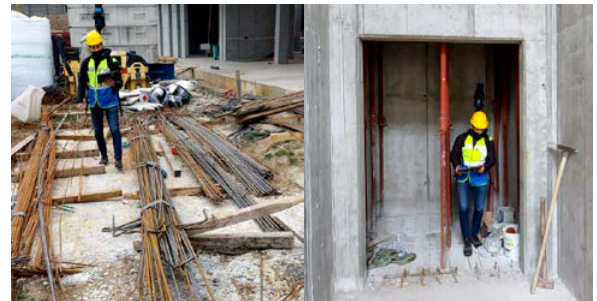
Figure 4. Mapping the construction site with the